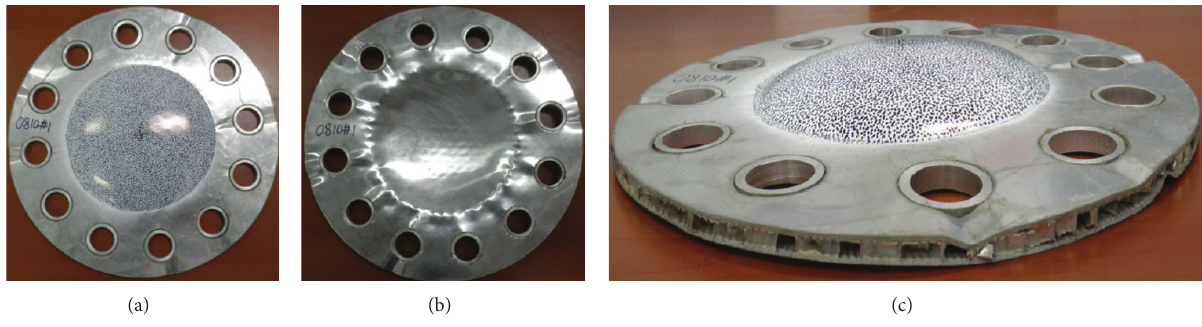
Figure 11: Cross section of sandwich panel after impulsive loading. The upper panel is the case of ̂𝐼 = 0.712 .